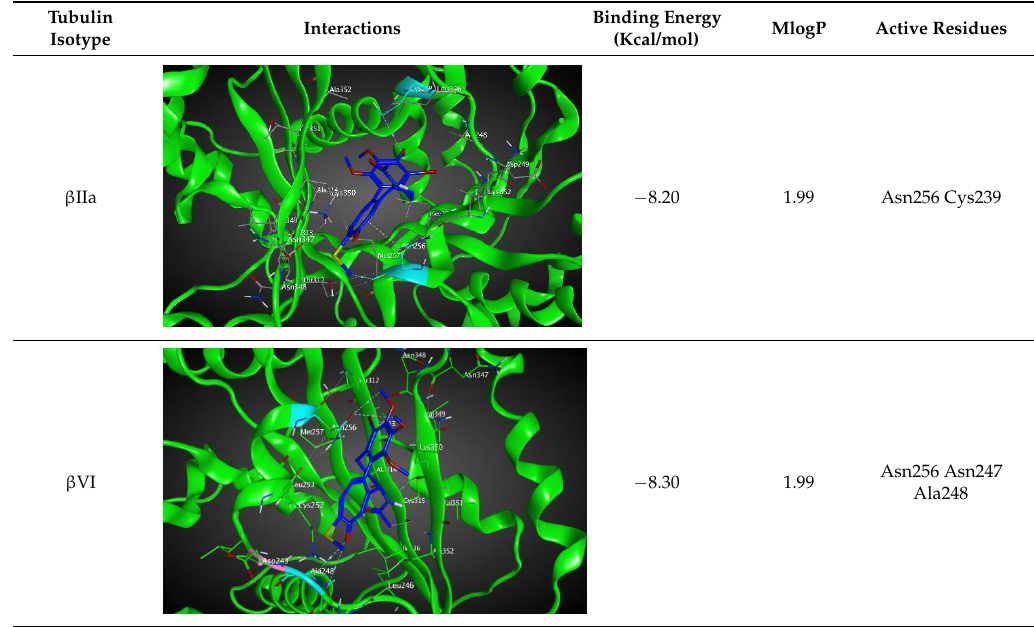
Table 4. Binding energies interactions between compound 8 and β IIa and β VI tubulin as well as the estimated Moriguchi octanol-water partition coefficient, MlogP for compound 8 .